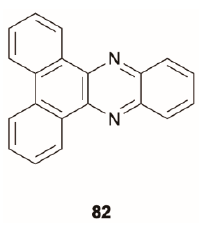
Scheme 28. Chemical structure of compound 82 .